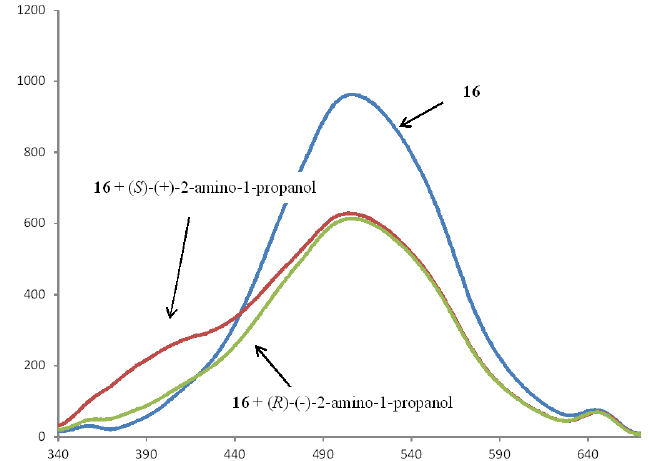
Figure 6. Fluorescence spectra of compound 16 in the presence of ( R )- and ( S )-enantiomers of leucinol (1000 equiv.).